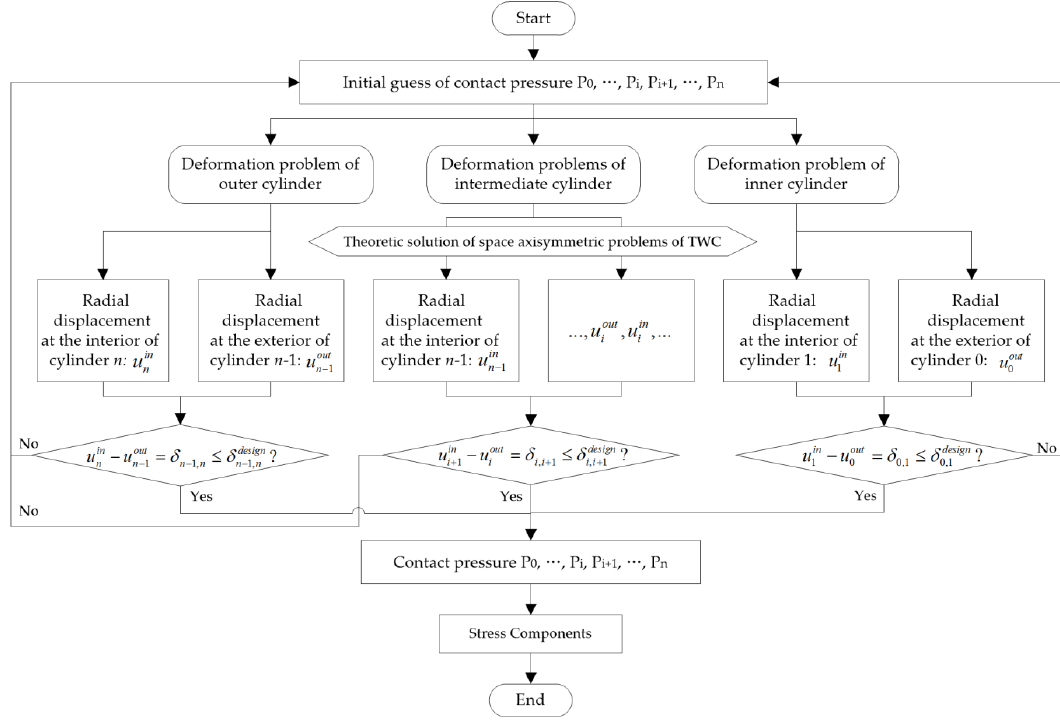
Figure 8. Sketch of interference fit of MLTWC.